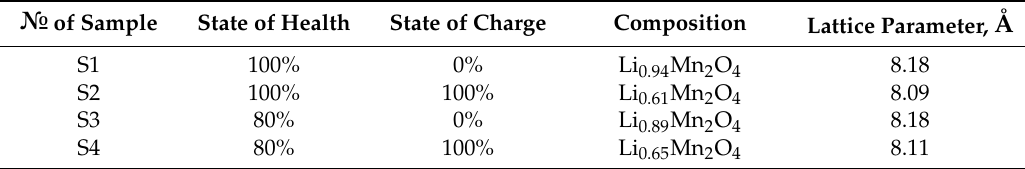
Table 1. Electrochemical state of studied LiMn 2 O 4 cathodes.